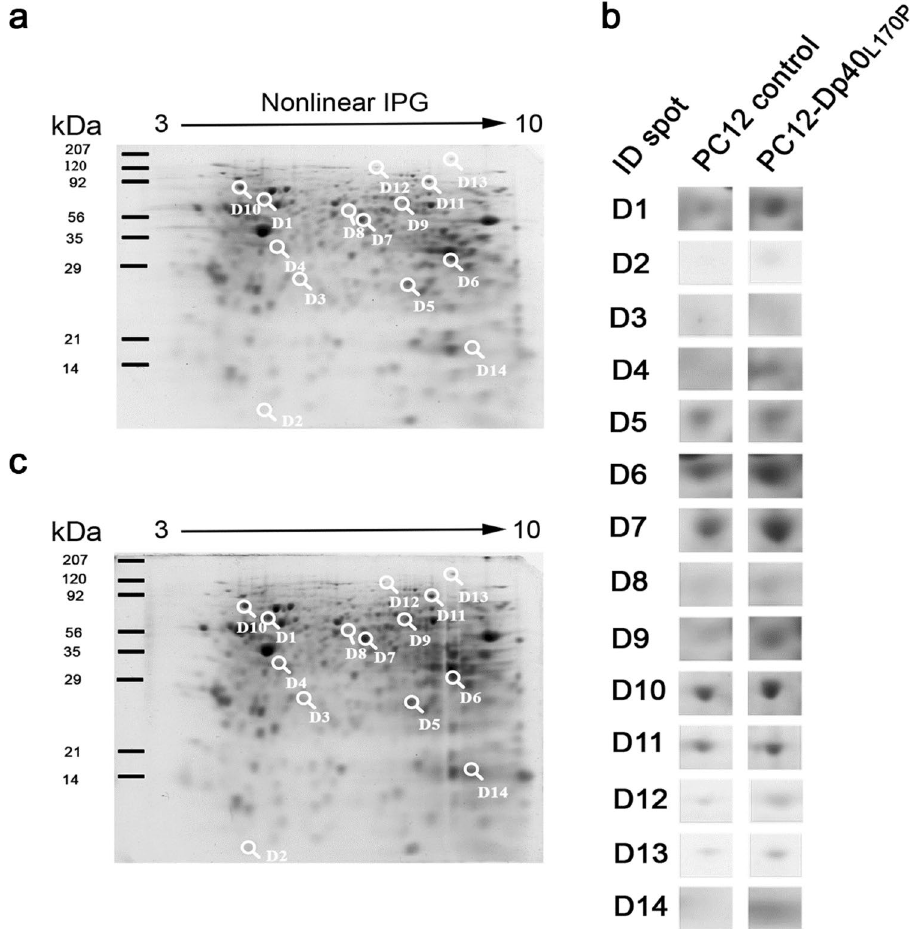
Figure 2. Two-dimensional gel electrophoresis images of proteins from the NGF-differentiated PC12 control and PC12-Dp40 L170P cells. Total protein extracts of the NGF-differentiated PC12 control and PC12-Dp40 L170P cells from three independent experiments were collected after differentiation for 9 days and separated by isoelectric focusing using immobilized pH nonlinear strips (7 cm), followed by SDS-PAGE. Gels were stained with coomassie colloidal blue. ( a ) Protein profile of the PC12 control cells and ( b ) the PC12-Dp40 L170P cells. Numbers 1–14 indicate the IDs of the differentially expressed protein spots. ( c ) Magnified views of the differentially expressed protein spots. Arrows represent the nonlinear immobilized pH gradient used for IEF. The positions of standard markers for the second dimension are shown on the left side of each